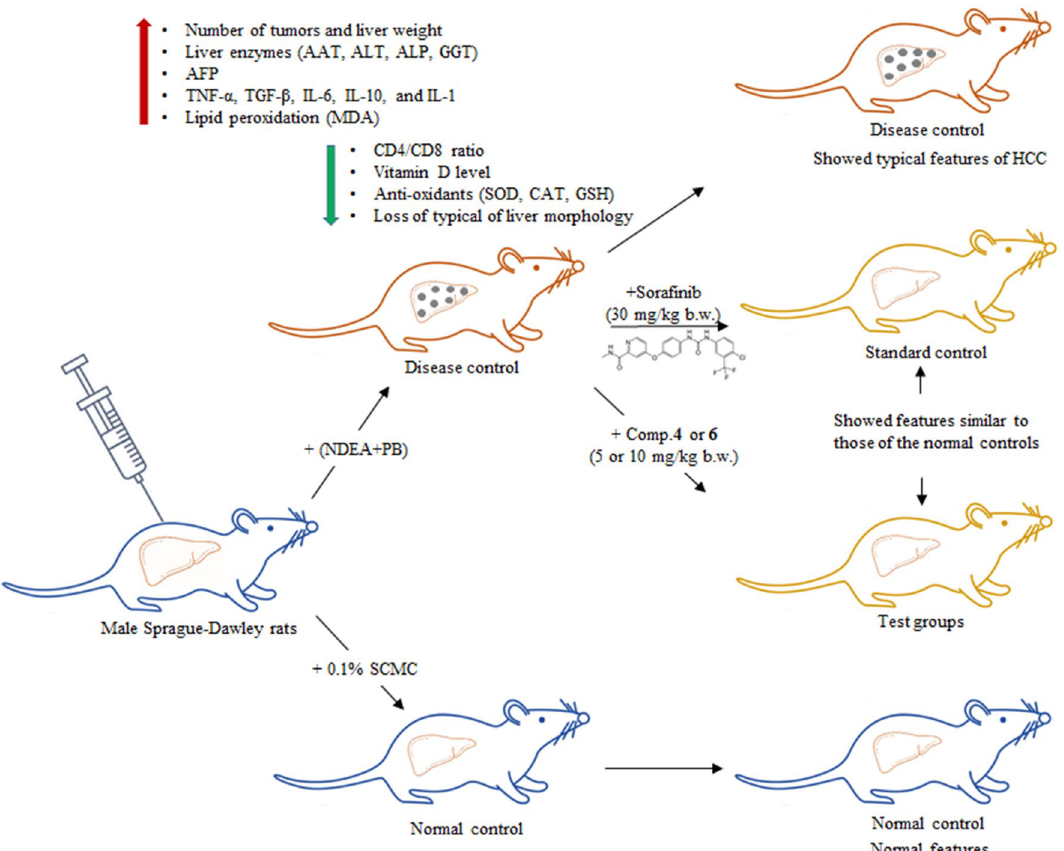
Figure 6. General experimental procedure and the key protective effects of compounds 4 and 6 against (NDEA + PB)-induced HCC in rats. HCC: hepatocellular carcinoma; SCMC: sodium carboxymethyl cellulose; NDEA: N -nitrosodiethylamine; PB: phenobarbital sodium; Comp.: compound; b.w: body